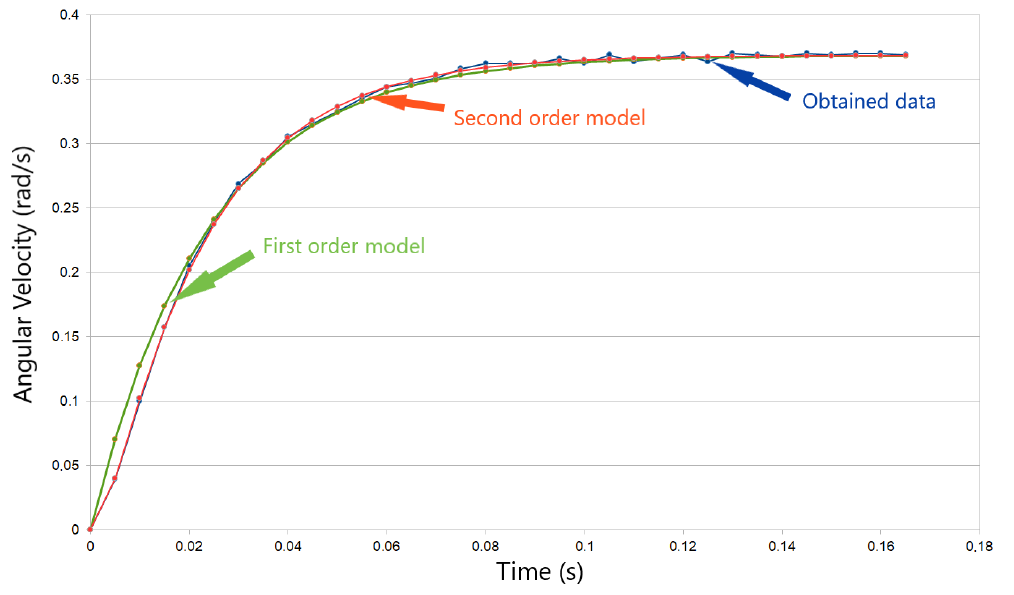
Figure 10. Plot of Angular Speed vs. Time.